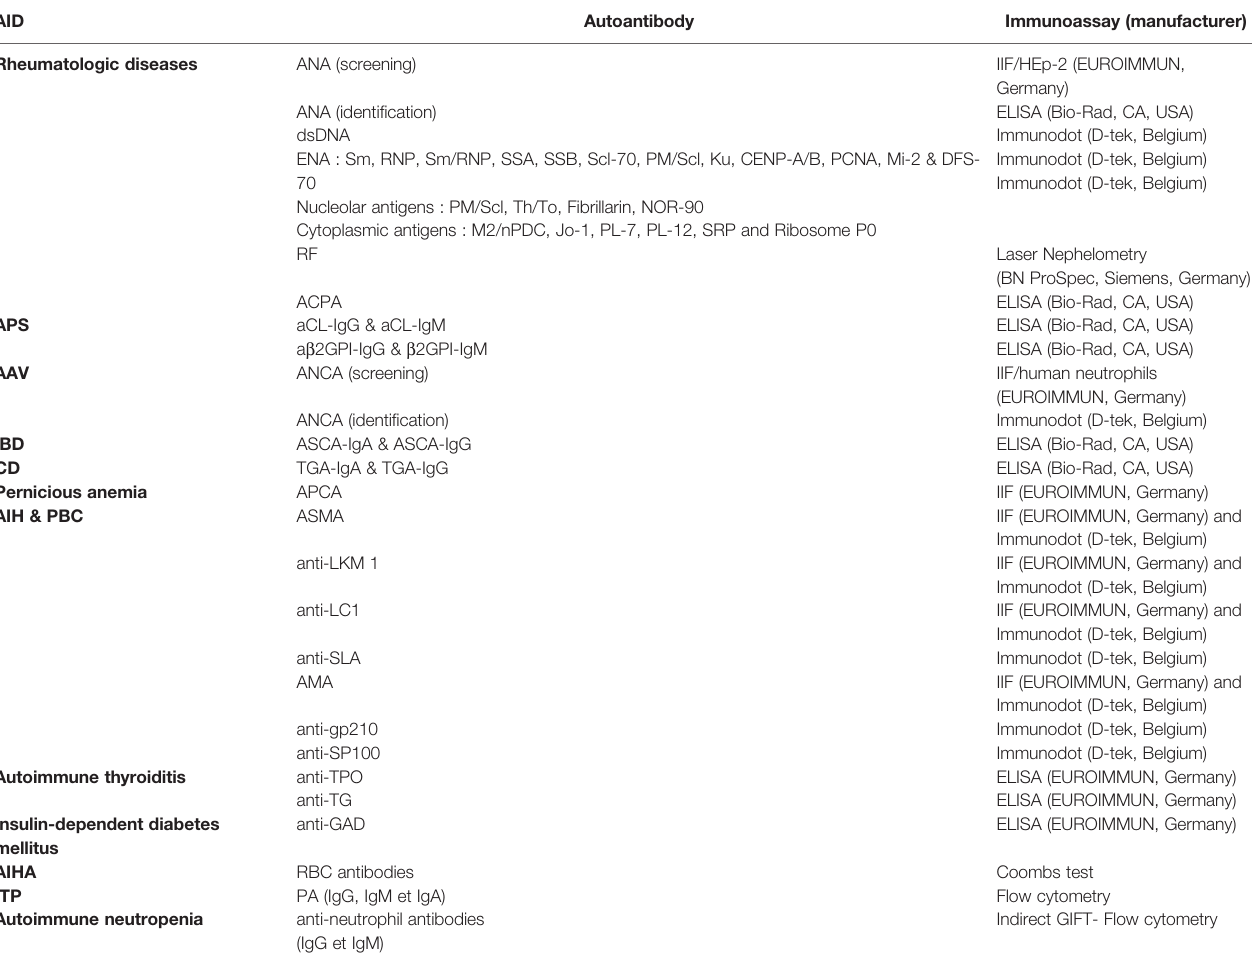
TABLE 1 | Immunoassays used for antibody